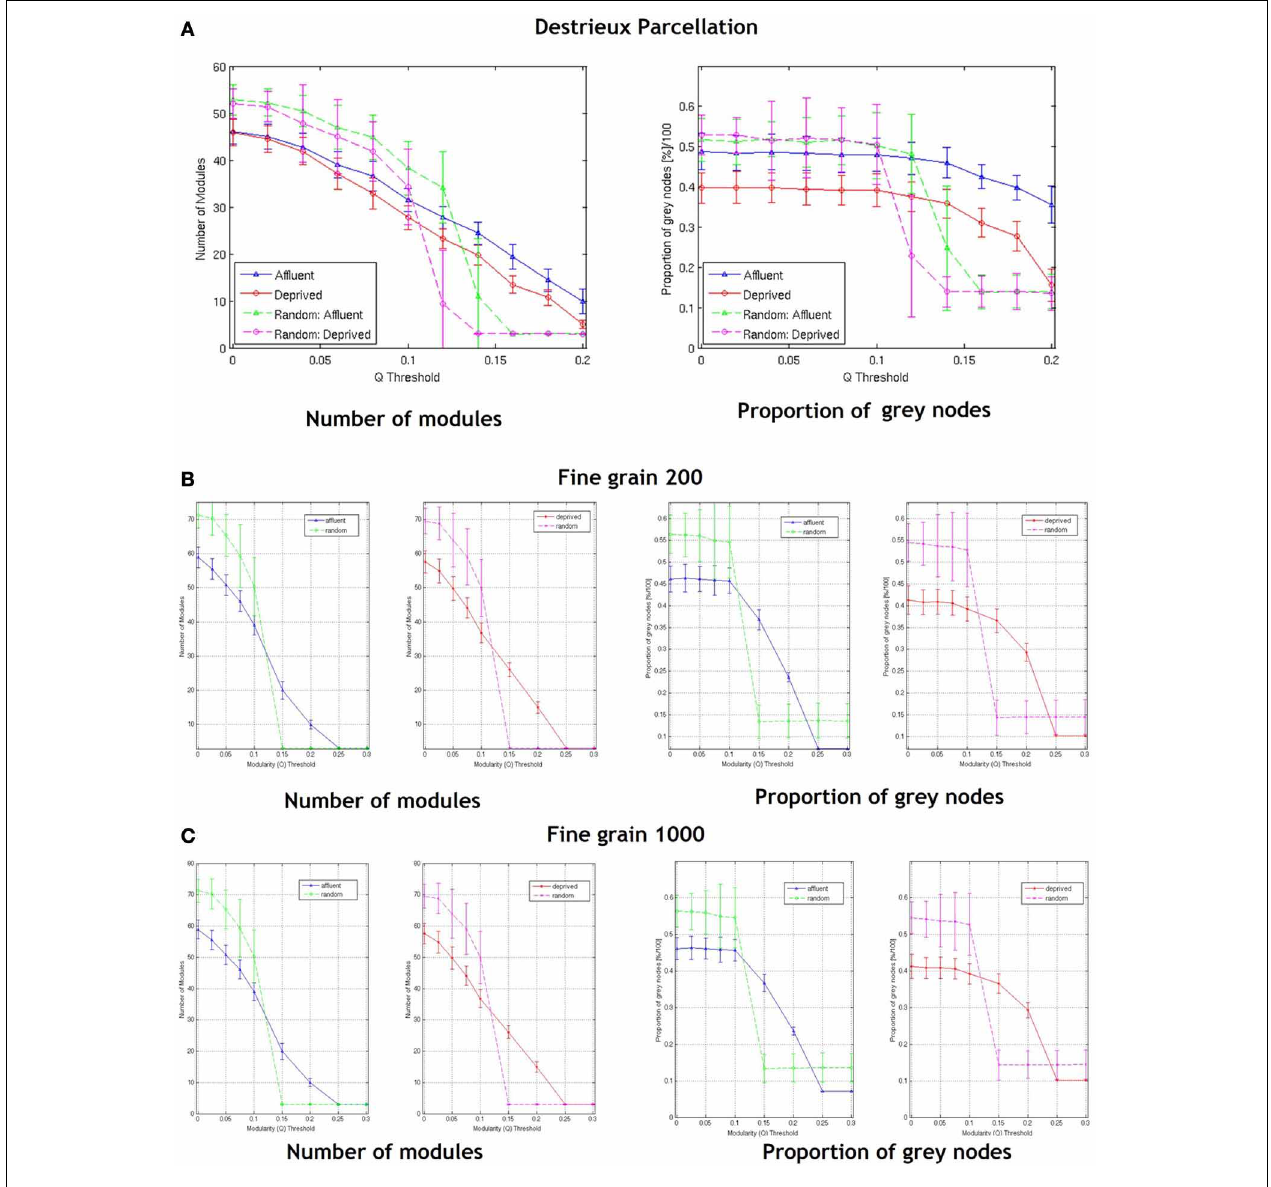
FIGURE 11 | Shows the number of modules and proportion of gray nodes at a fine grain level—(A) parcellation following sulcogyral boundaries—Destrieux atlas (148 parcels) and (B) a